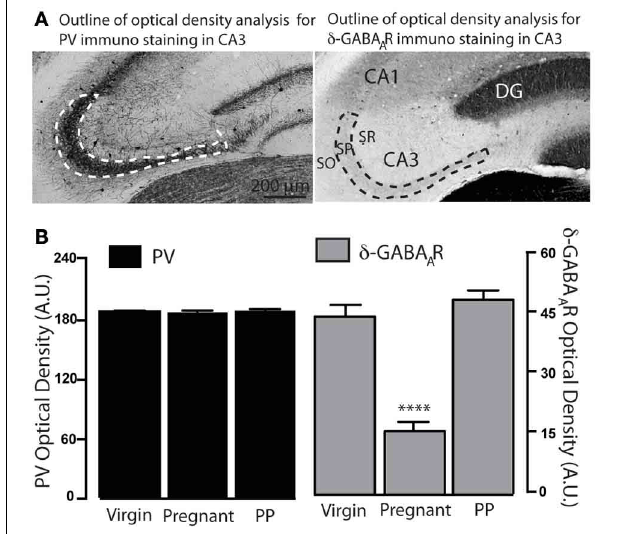
FIGURE 5 | Semi quantitative optical density analysis of PV and δ -GABA A R immunolabeling across different gestational states. (A) Representative bright-field images of CA3 PV and δ -GABA A R-specific DAB staining. Dotted lines delimit the boundaries of the area analyzed (CA3 stratum pyramidale) for optical density measurements. (B) Optical density measurements (arbitrary units, A.U.) show a significant reduction in δ -GABA A R expression in pregnant animals. No difference is found in PV expression across gestational states. Asterisks denote significance, p < 0 .